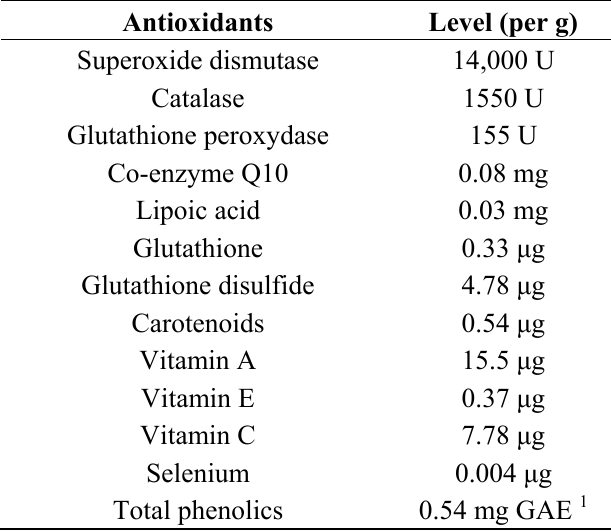
Table 1. Antioxidants composition of Extramel ®